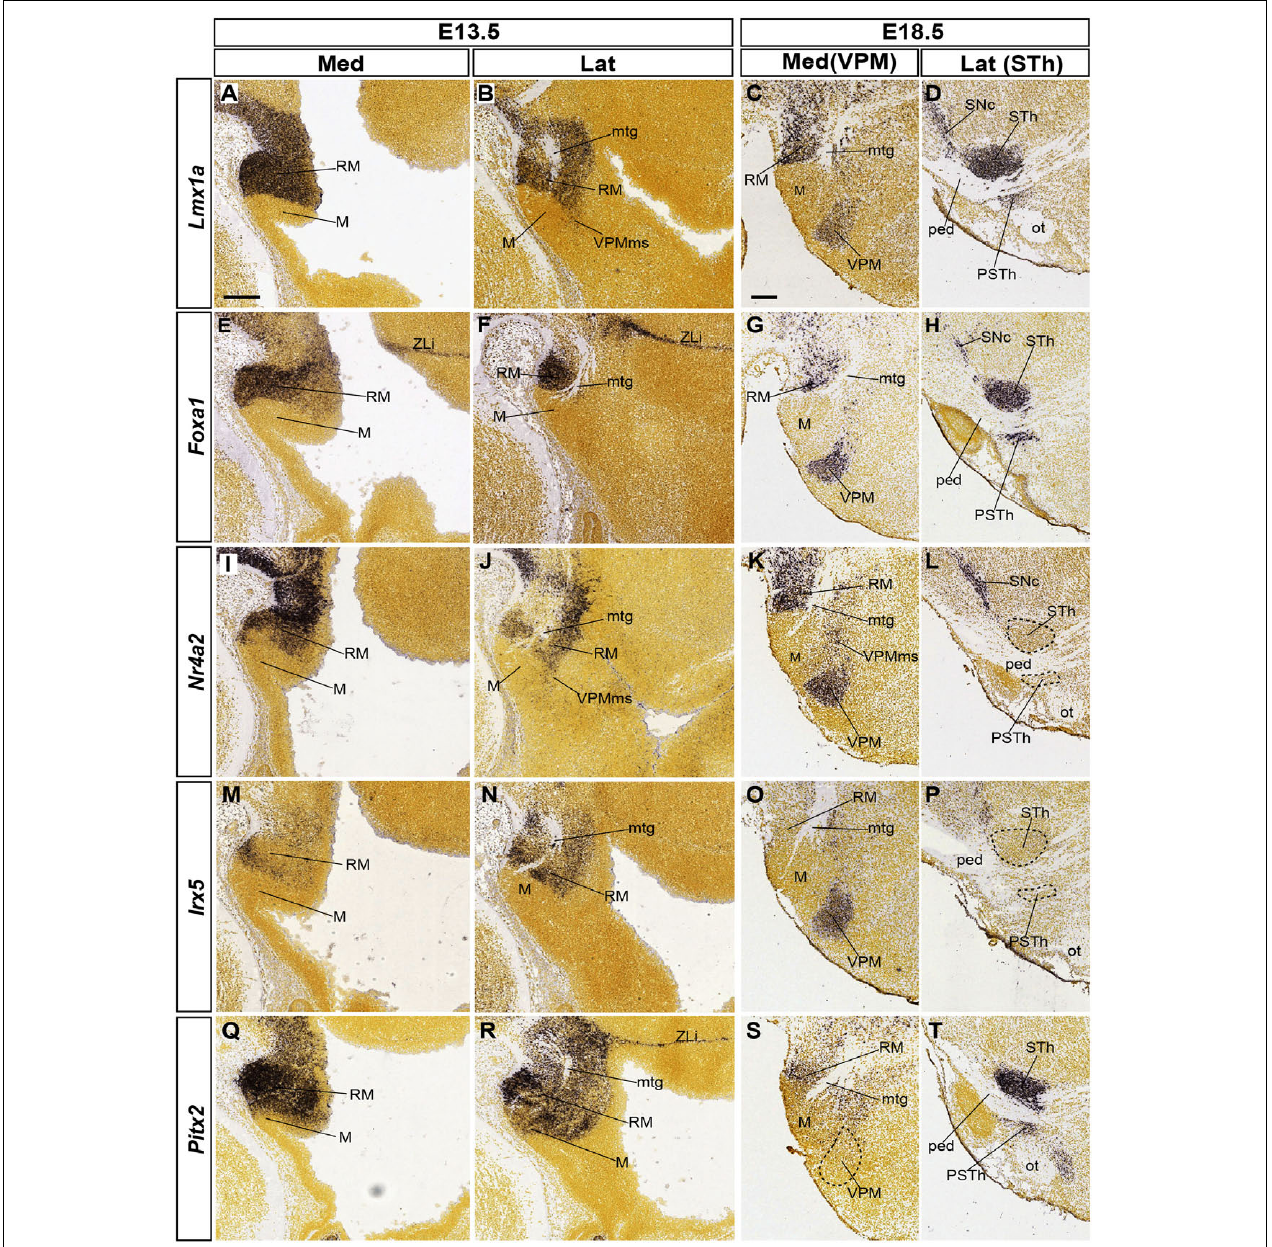
FIGURE 6 | Various retromamillary markers and their differential involvement in tangential migrations. The five indicated gene markers are expressed at least partially in the RM area at E13.5 (medio-lateral sagittal sections in A,B,E,F,I,J, M,N, Q,R ; sagittal images from the Allen Developing Mouse Brain Atlas). Comparison with equivalent medio-lateral sections at E18.5 (C,D,G,H, K,L,O,P,S,T) shows three sorts of results regarding the possible labeling of either VPM or STh/PSTh populations migrated out of the RM area: Lmx1a and Foxa1 label both derivatives (VPM, STh/PSTh in C,D,G,H ); Nr42 or Irx5 label only VPM (K,L,O,P) ; Pitx2 labels only STh/PSTh (S,T) . Scale bars represent 200 µ